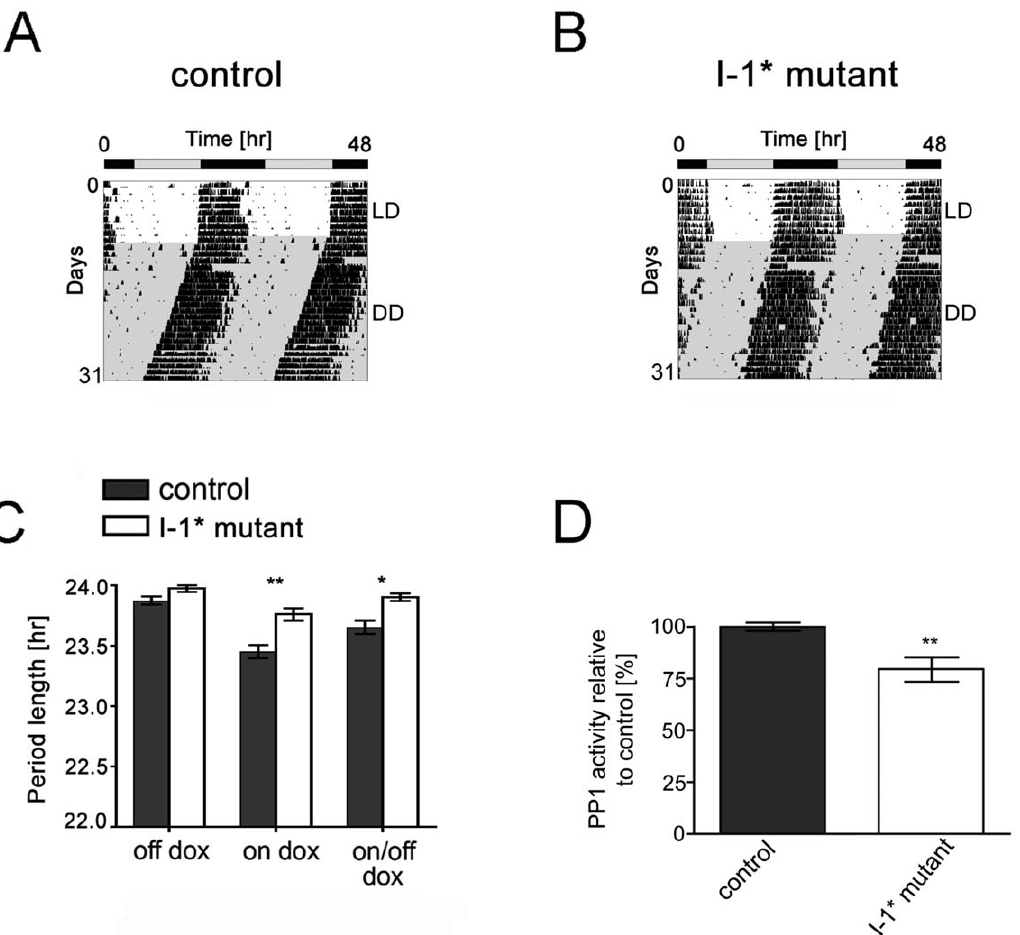
Figure 2. Dox-dependent and reversible lengthening of the circadian period of I-1* mutant animals. (A, B) Representative locomotor activity records of control (A) and I-1* mutant mice (B) under doxycycline treatment. Wheel-running activity is shown under free-running conditions in constant darkness (DD). (C) Average period length of control and I-1* mutant mice as determined by x 2 -periodogram analysis under off dox, on dox and on/off dox conditions. Data are represented as mean 6 SEM: control (off dox 23.88 6 0.03 h, n=14; on dox 23.45 6 0.06 h, n=14; on/off dox 23.65 6 0.05 h, n=14), I-1* mutant (off dox 23.98 6 0.03 h, n=9; on dox 23.76 6 0.05 h, n=9; on/off dox 23.90 6 0.03 h, n=9); ** p , 0.01, * p , 0.05 indicating significance (2-way Anova with Bonferroni post-test). (D) PP1 activity (% total activity) was measured in extracts from SCN tissue in control and I-1* mutant mice under doxycycline treatment. PP1 activity of control animals was set to 100% and mutant values were calculated in relation. Represented is the mean 6 SEM (n=8, ** p , 0.01 indicating significance (unpaired